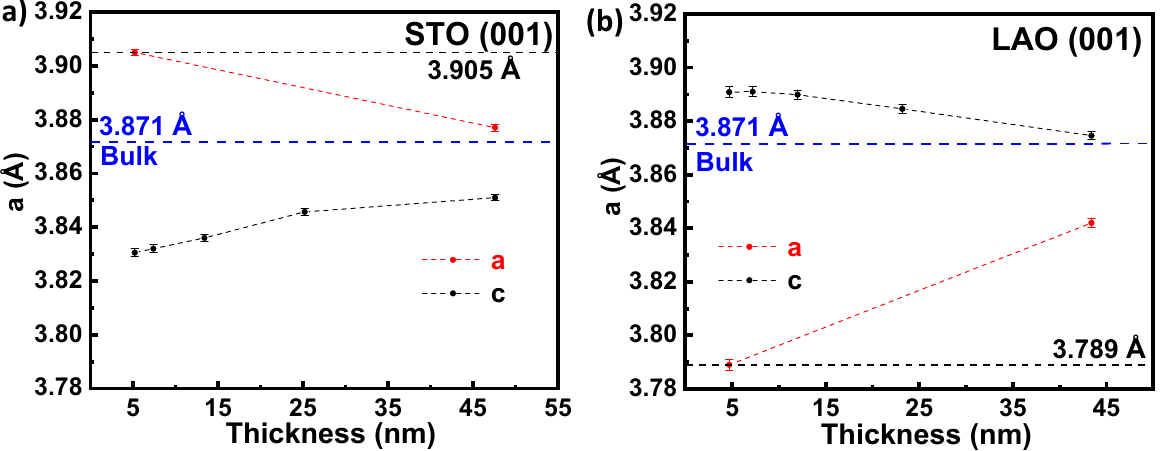
Figure 3. ( a , b ) variation of in-plane (red dashed line) and out-of-plane (black dashed line) lattice parameters of PNMO films as a function of thickness deposited on STO (001) and LAO (001) substrates. The blue and black dashed line represents the bulk counterpart value and the substrate lattice parameter.